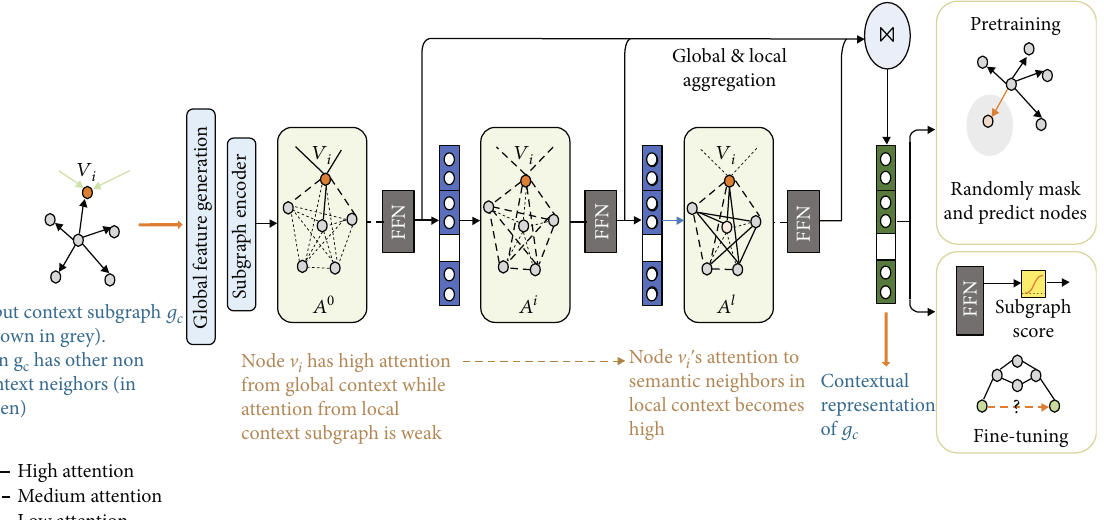
Figure 4: “ Self-supervised learning of contextual embedding of link-based link prediction.